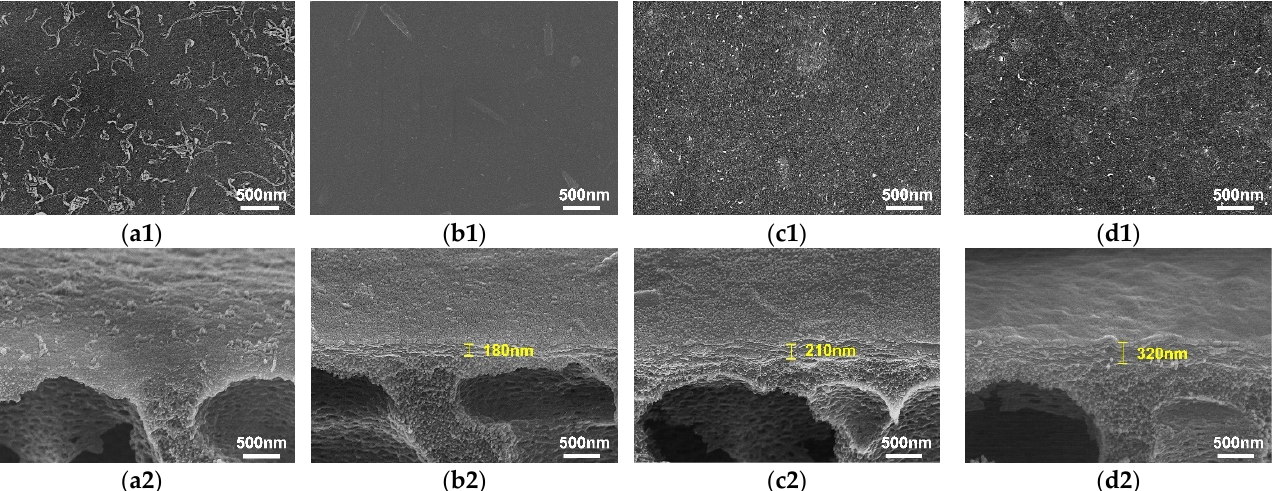
Figure 2. The XRD patterns of the CoAl-LDH membrane and CNTs/LDH membranes with different mass fractions of CNTs (1 wt.%–5 wt.%).